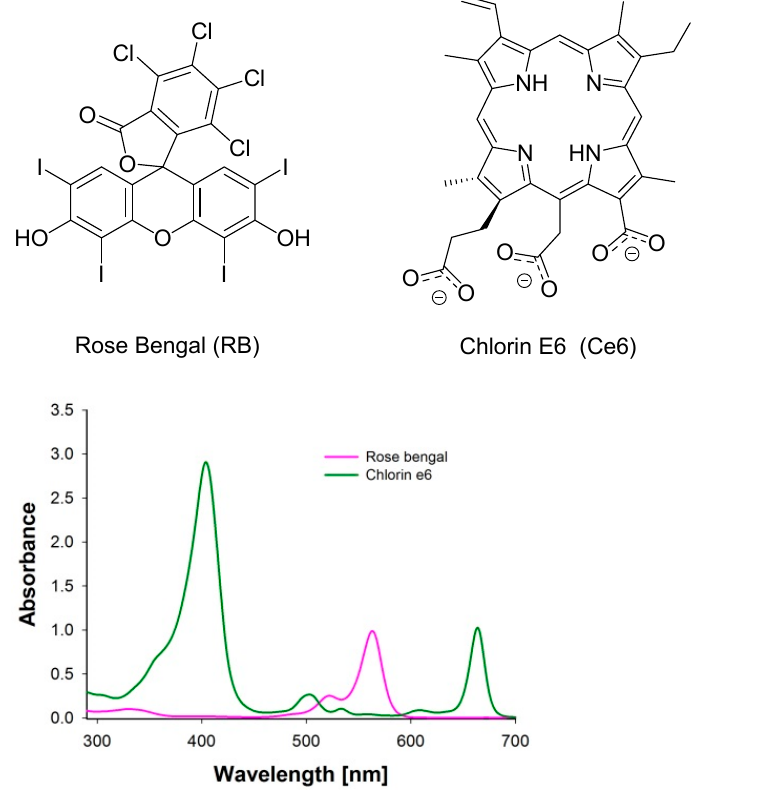
Figure 1. Molecular structure of rose bengal (RB) and chlorin e6 (Ce6) and their absorption spectra.